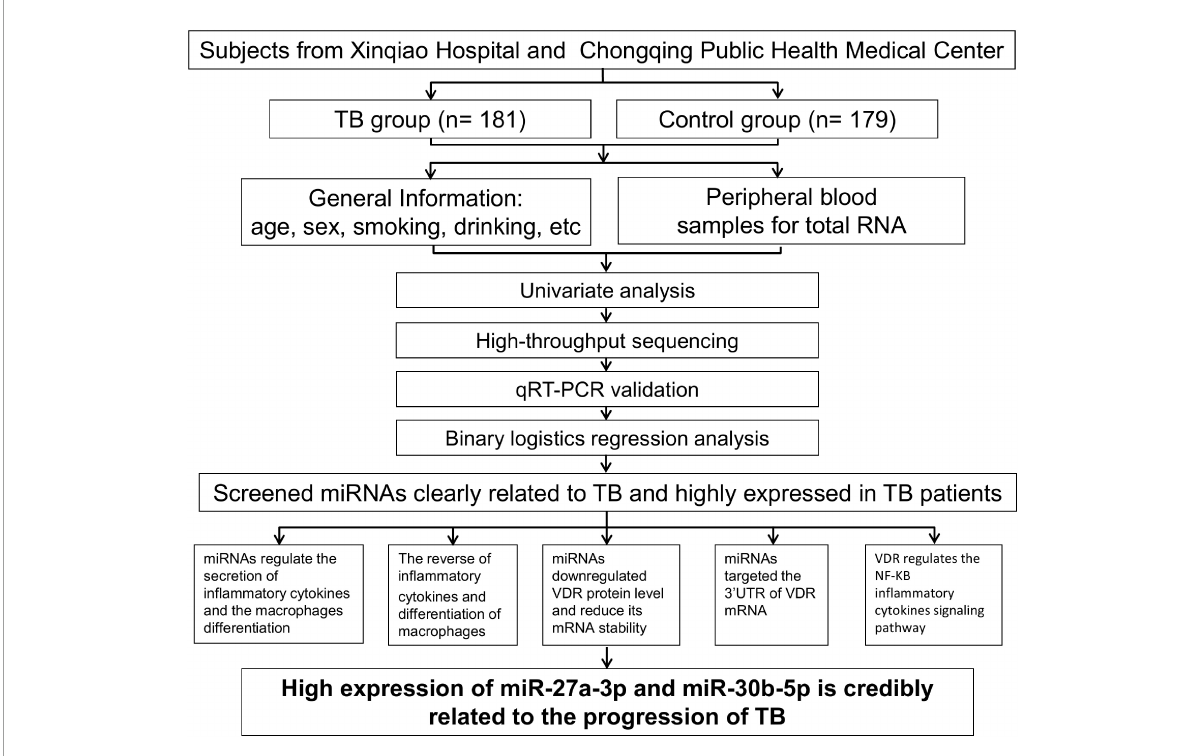
FIGURE1 Flow chart. The summary of the current study’s logical